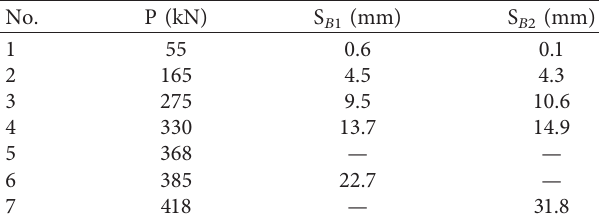
Table 6: Pullout test results from example 2.